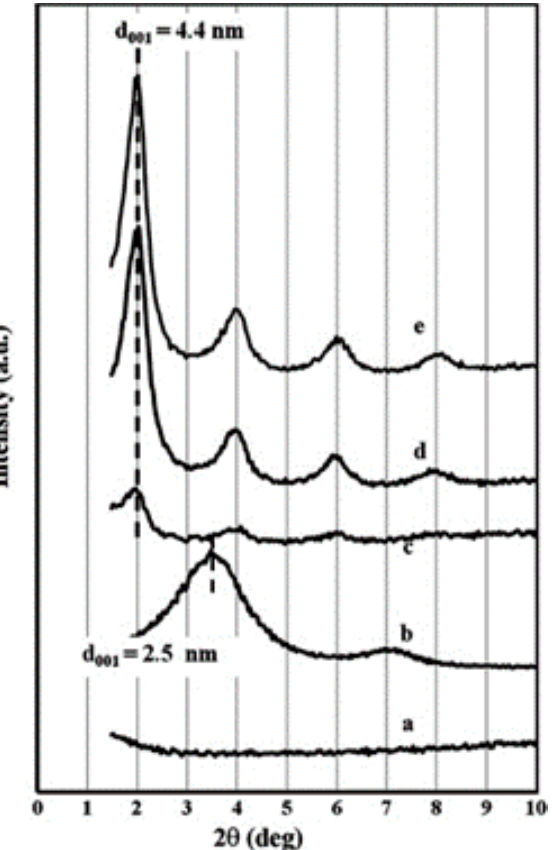
Figure 12. XRD pattern of neat bitumen, Closite 20A, SBS/20A, B/20A, B/SBS/20A (PM) and B/SBS/20A (MB) (reprinted from [136] with the permission of Elsevier).